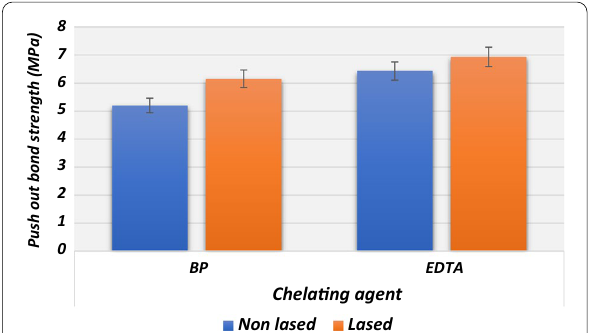
Fig. 1 Column chart comparing total Push out bond strength mean values as impact of chelating agent group with/out laser